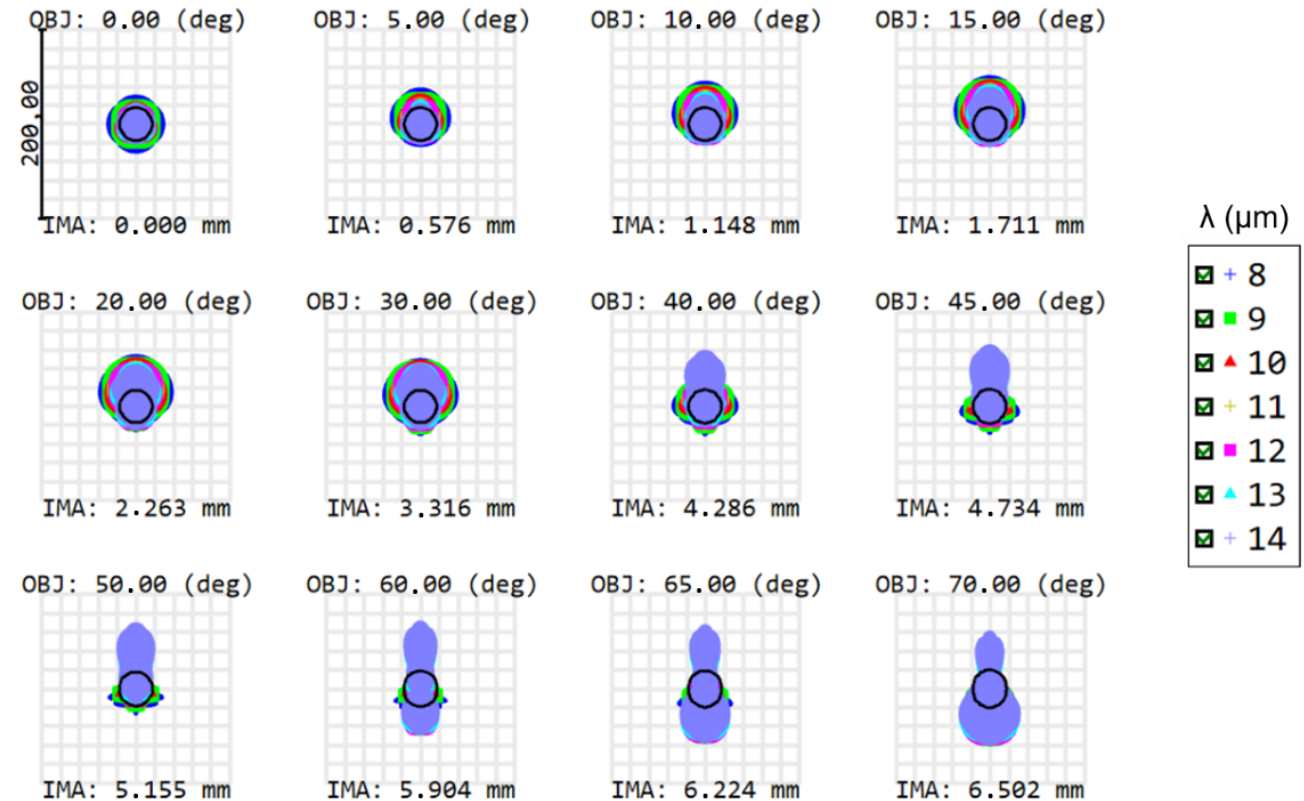
Figure 2. Spot sizes for fields between 0° and 70°, for all wavelengths between 8 and 14 µ m (as visualized by the different colors in each spot plot). The Airy disk radii (black circles) equal 17.28 µ m. Based on the spots, the system shows a good image quality. OBJ (in degrees) defines the object field and IMA (in mm) defines the image height of the centroid on the detector. This figure indicates that the best performance is obtained on-axis, while off-axis spots show less favorable performance.